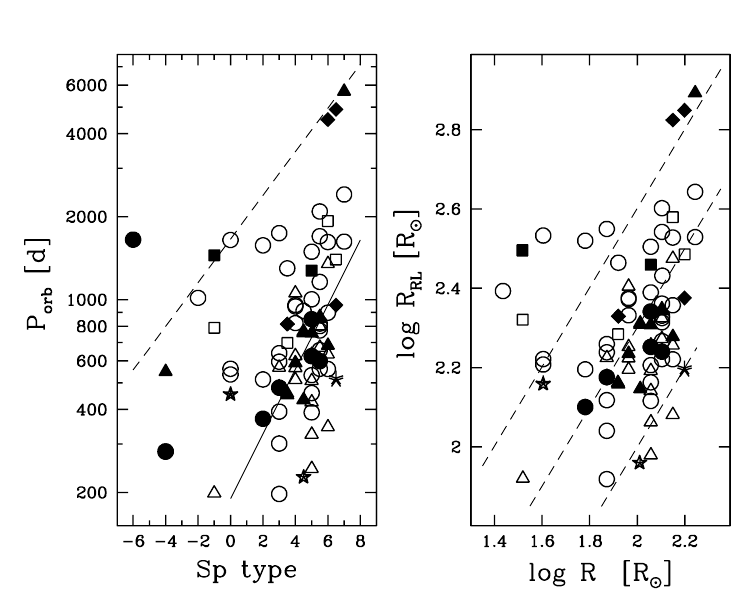
Fig. 2. Left . Orbital periods as a function of the spectral types. Different symbols represent different activity classes: recurrent (stars) and ordinary (diamonds) symbiotic novae, systems with Z And-like activity (triangles), systems without recorded outbursts (circles) and systems with enhanced activity related to the periastron passage (squares). The filled symbols denote objects included in M¨urset & Schmid (1999). The lines make the period limits found by M¨urset & Schmid (1999). Right . The Roche lobe radius versus the cool giant’s radius, as derived from the spectral type, for systems with K- and M-type giants. Lines denote R RL = R , R RL = 2 R , and R RL = 4 R ,